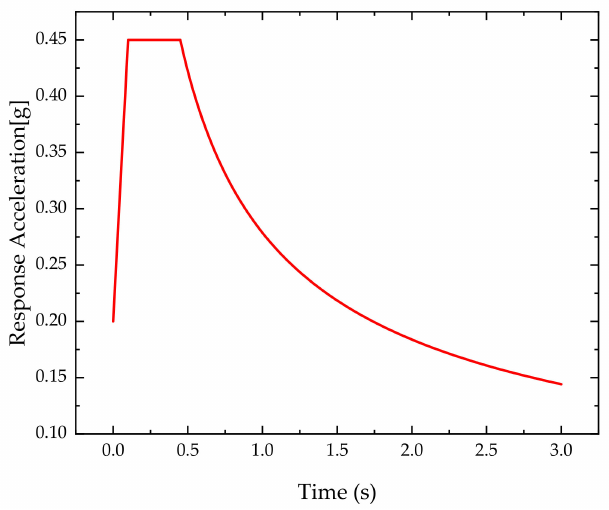
Figure 5. The design response spectrum. The first nine groups of ground motions selected by the utility of the NGA-West2 On-Line Ground-Motion Database Tool are shown in Figure 6.